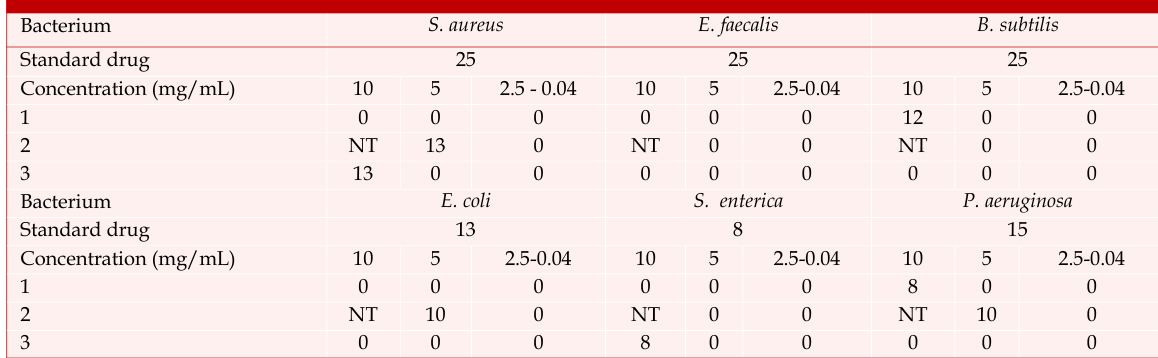
Inhibition of bacterial growth by using different concentration of the